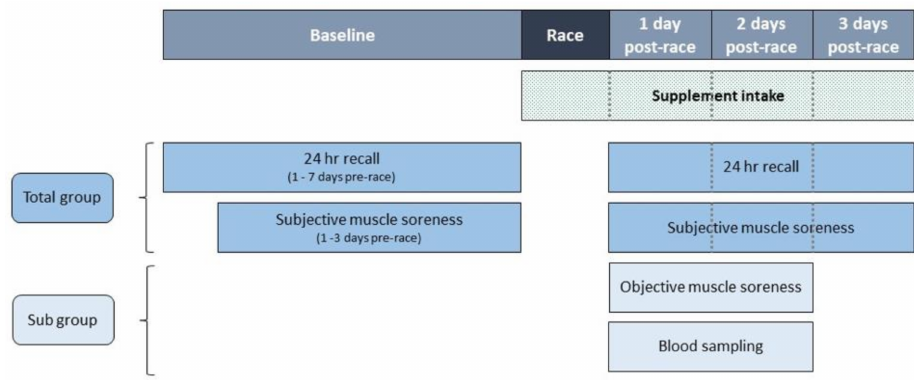
Figure 2. Schematic overview of the study